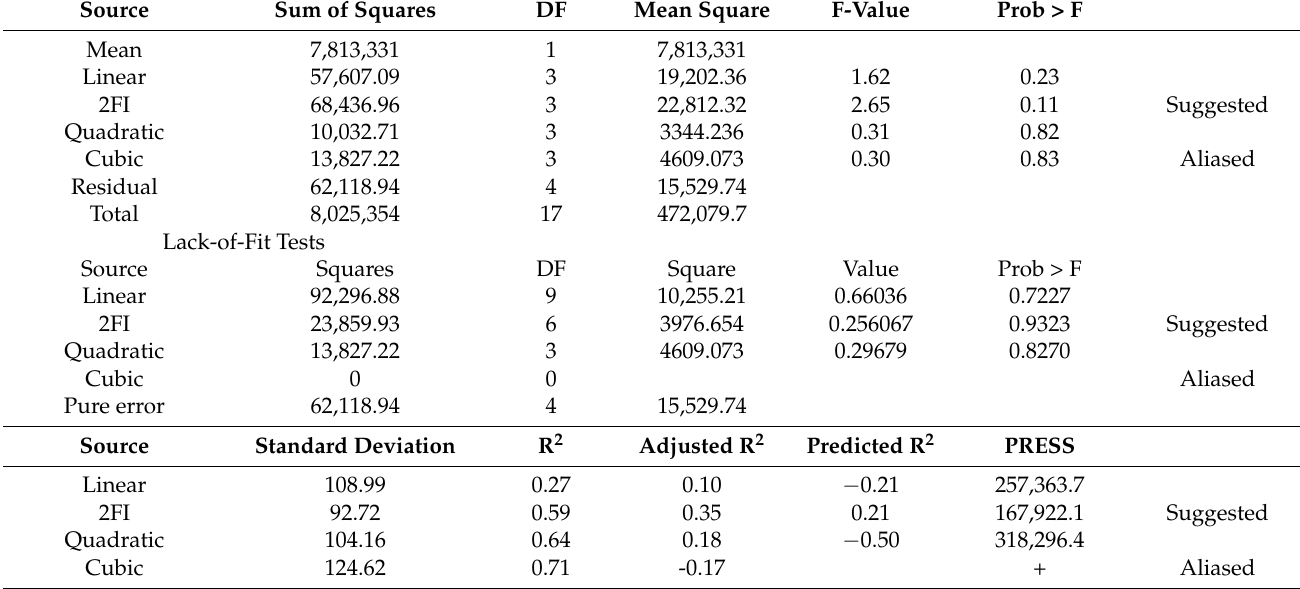
Table 7. Adequacy of the model for BET surface area